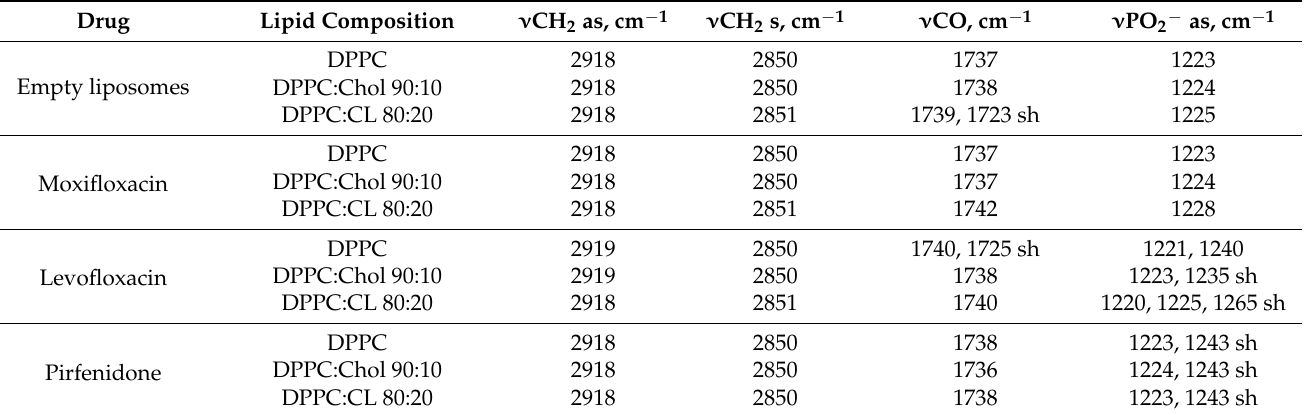
Table 2. Main band position on the ATR-FTIR spectra of liposomal forms of drugs. Total